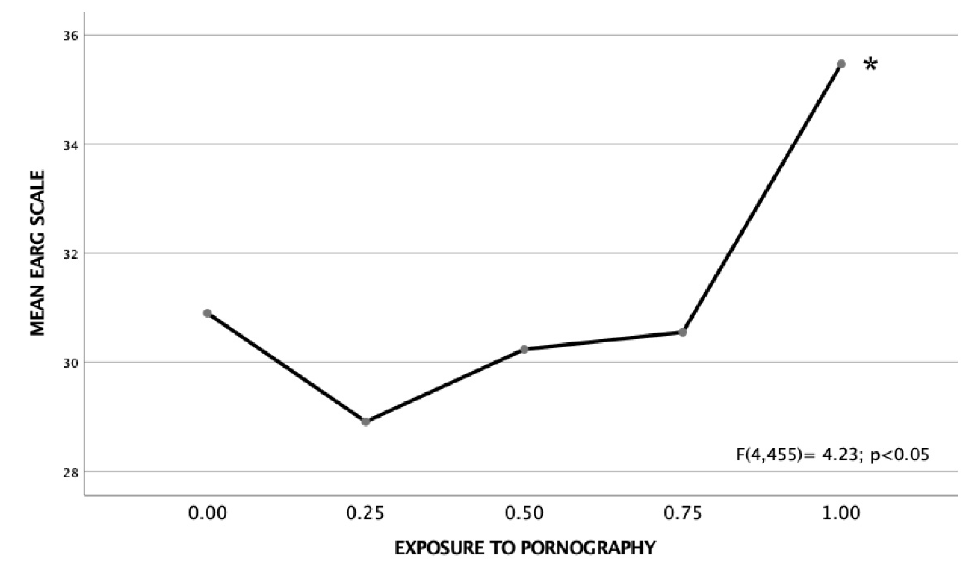
Figure 2. Mean of the EARG scale according to the degree of exposure to pornography (minimum 0, maximum 1). The higher the score, the greater the explicit gender role attitudes. (* Marks the group that presents significant differences from the rest of the groups; Tukey’s HSD ( p <